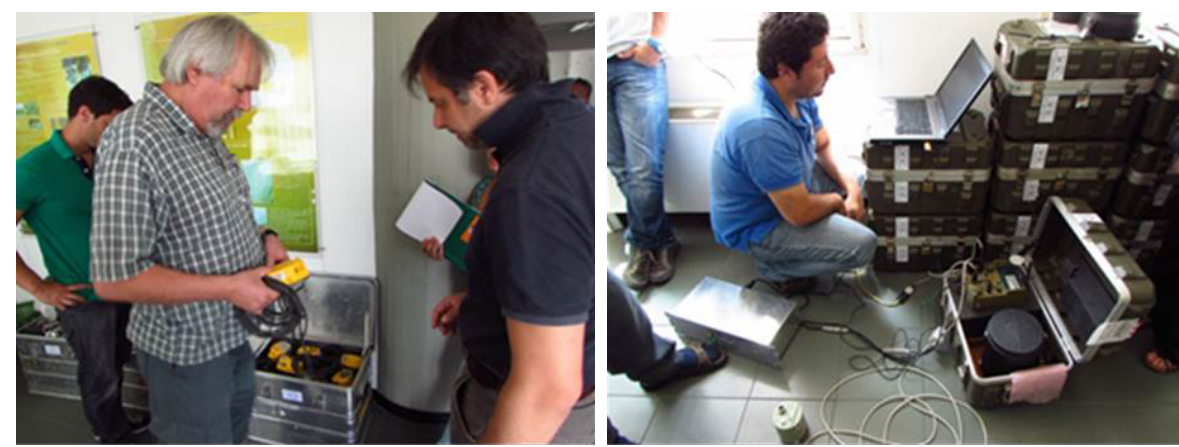
Figure 15. The first training lessons on the use of the seismic stations provided by Prof. B.-G. Lühr from the GFZ of Potsdam